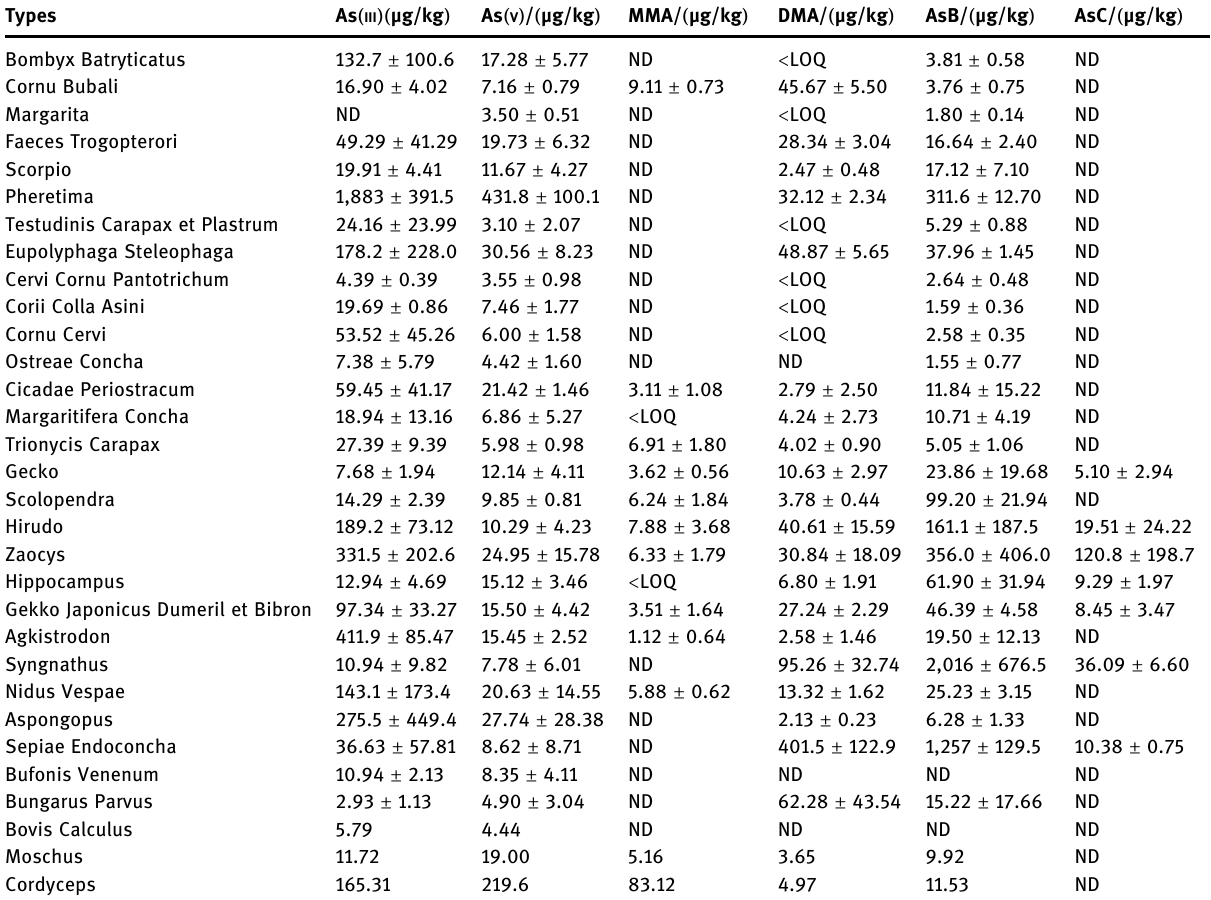
Table 2: The contents of As speciation in 31 animal